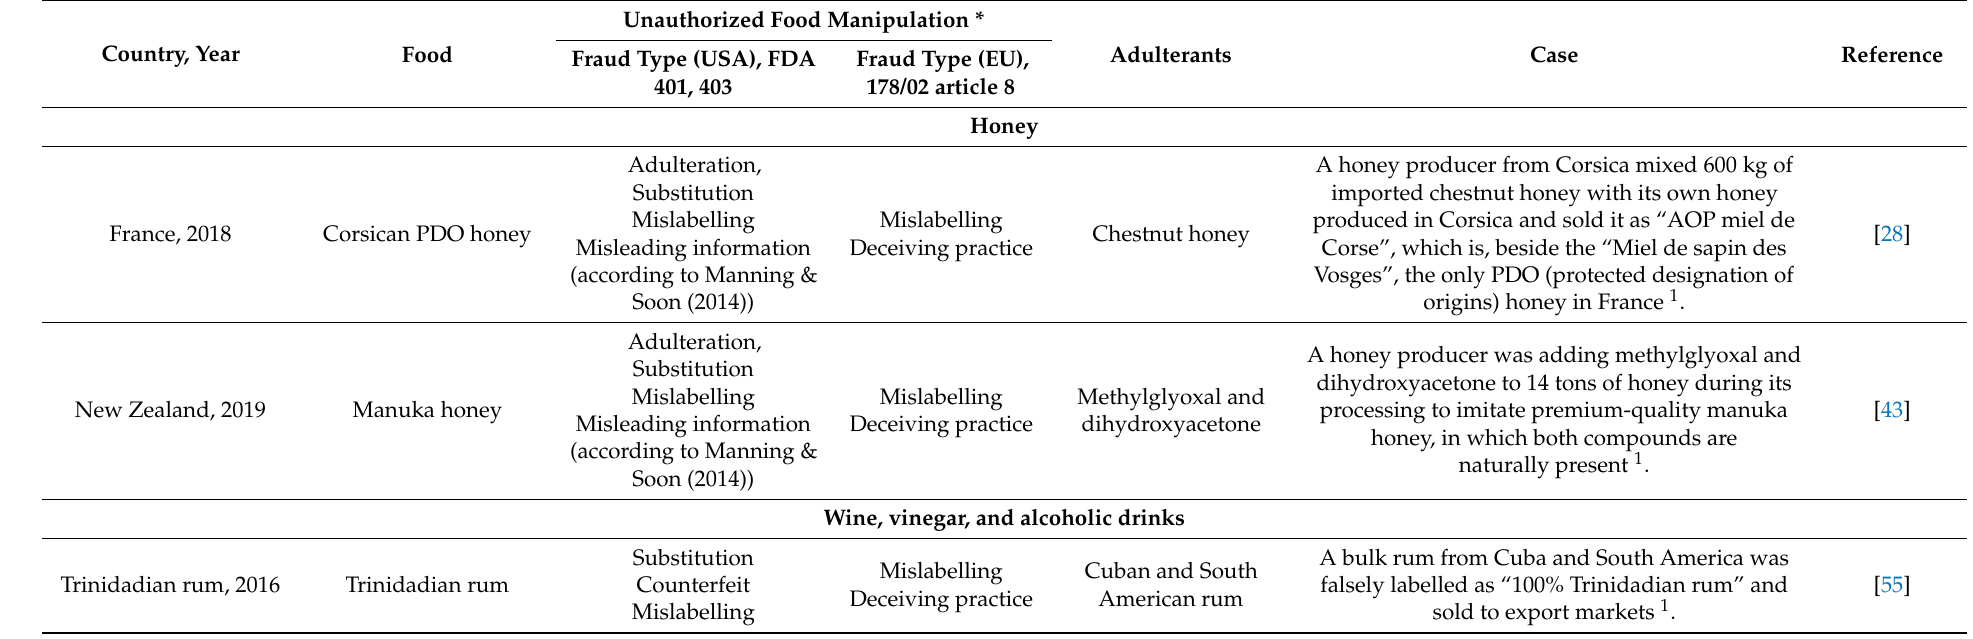
Table 2. Unauthorized Food Manipulation regarding origin masking,